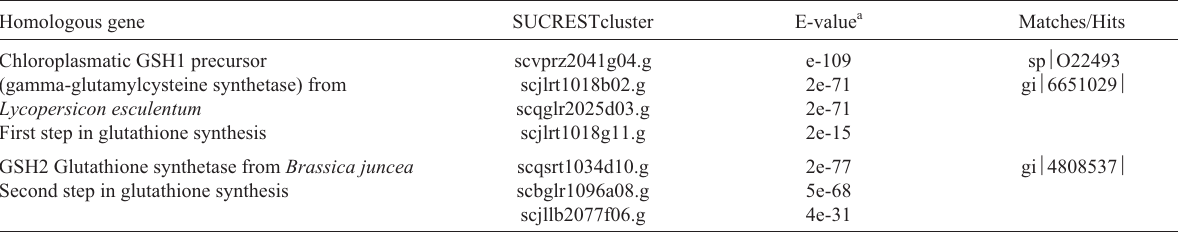
Table IV - Genes involved in glutathione biosynthesis in